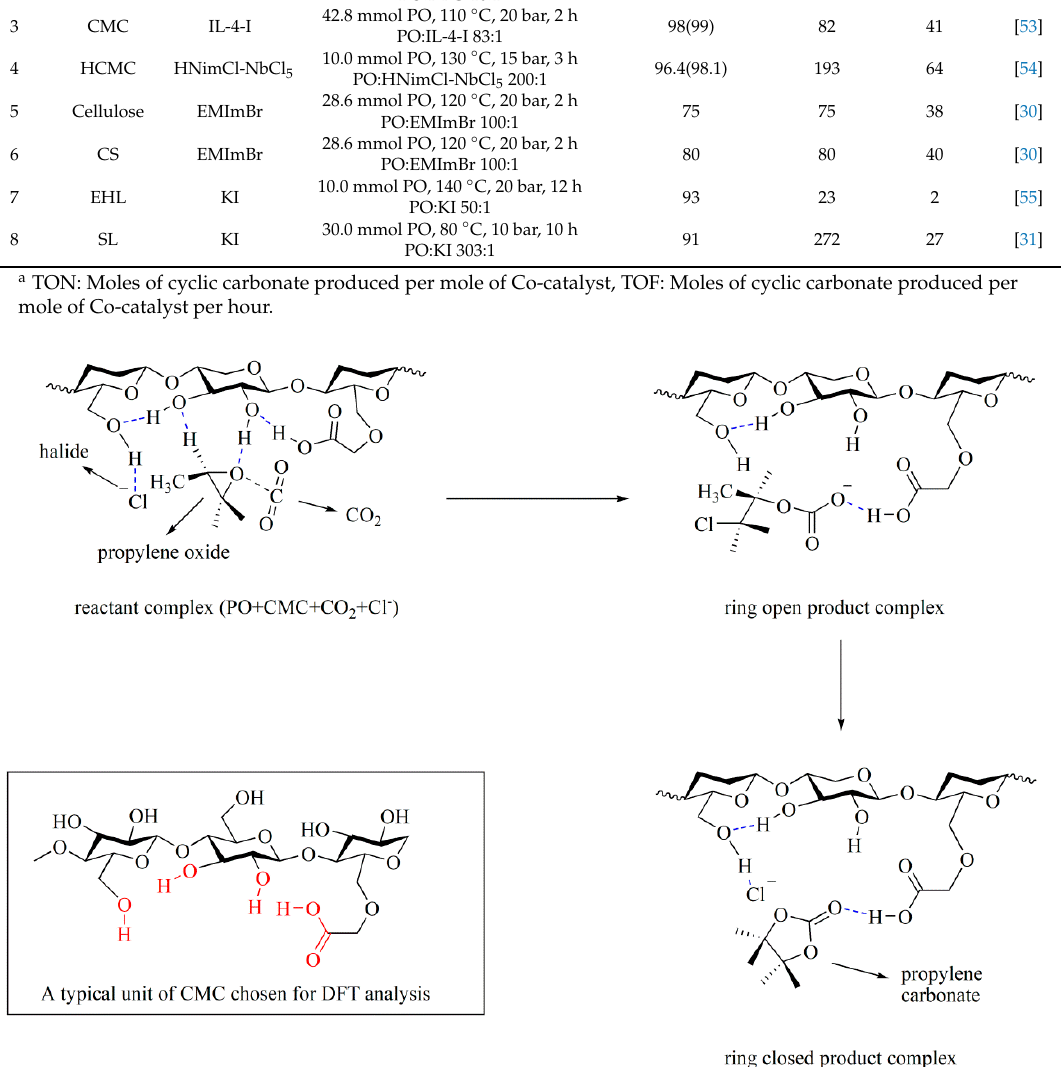
Scheme 5. Proposed mechanism of CMC-mediated catalysis (blue dotted lines indicate the hydrogen bonding; the black dotted line indicates the van der Waals interaction).